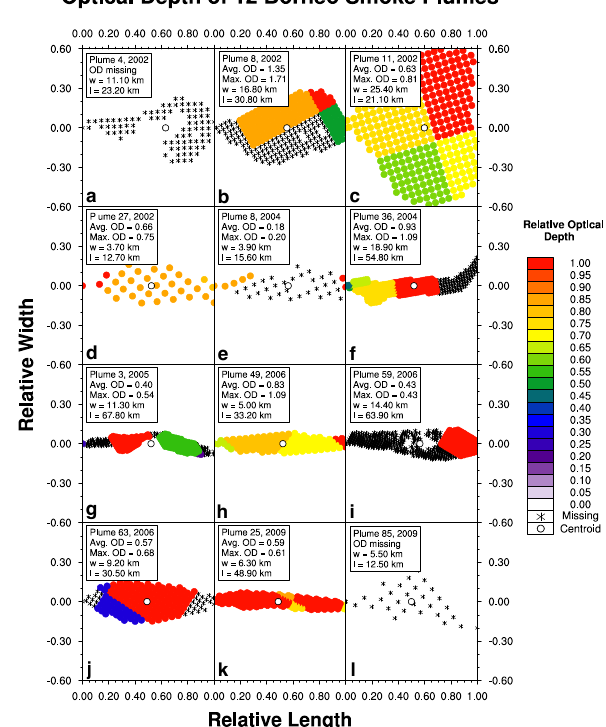
Fig. 1. Shape, area-weighted centroid, and relative optical depth of 12 representative plumes arranged chronologically. Information box in upper left indicates year and order the plume was imaged (e.g., (k) shows the 25th plume imaged in 2009), average plume op- tical depth, maximum optical depth, actual width, and actual